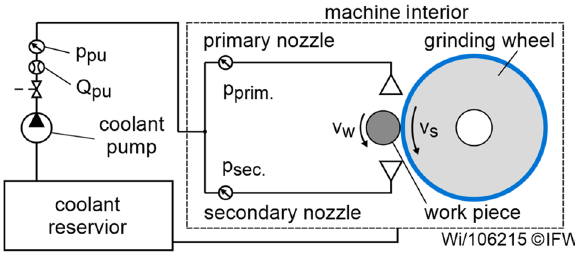
Fig. 2 Coolant supply for the Schaudt CR41 machine